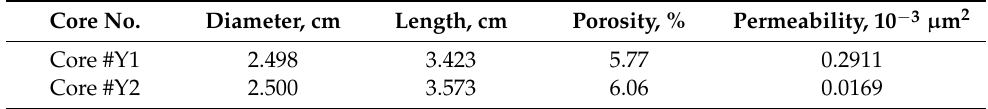
The oil used in this study was n-dodecane with a density of 0.7487 g/cm 3 and a vis- cosity of 1.508 mPa·s at 25 °C, and the calibration curve between n-dodecane and NMR Suzhou, China, with a purity of 99.9%.